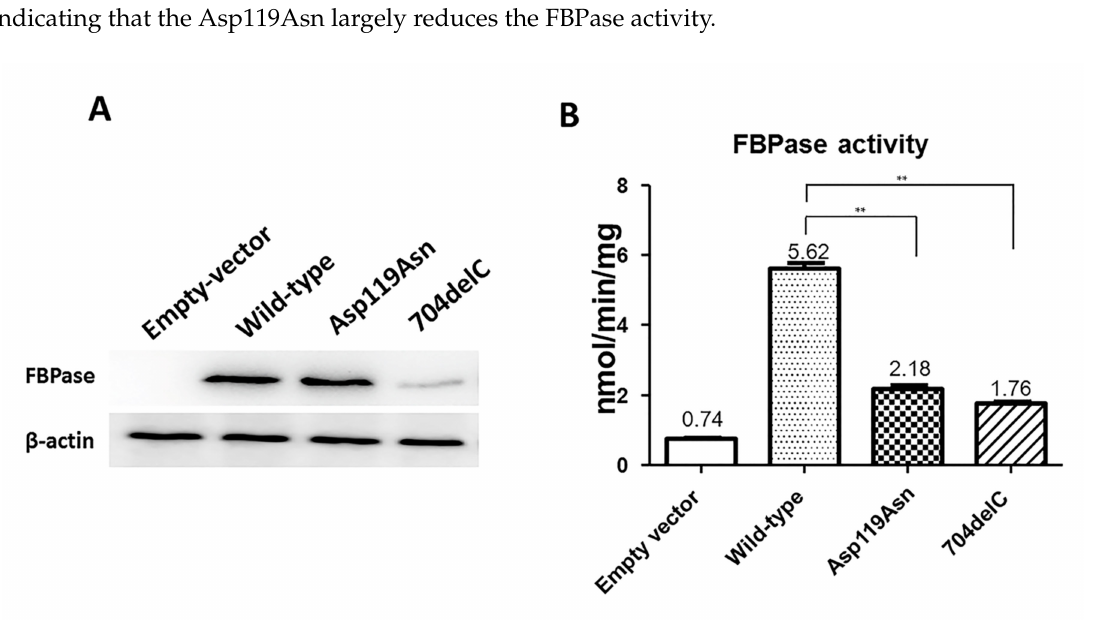
Figure 4. In vitro function studies of Asp119Asn and 704delC in COS-7 cell line. ( A ) The Western blotting results showed 704delC leads to a lower protein expression level as well as a slightly smaller protein size, Asp119Asn has no effect on the protein expression; ( B ) The FBPase activity of Asp119Asn and 704delC markedly decreased compared with that of the wild-type. The data represent mean values of FBPase activities performed three times. **: p value <